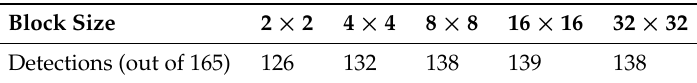
Table 2. Detected images per block